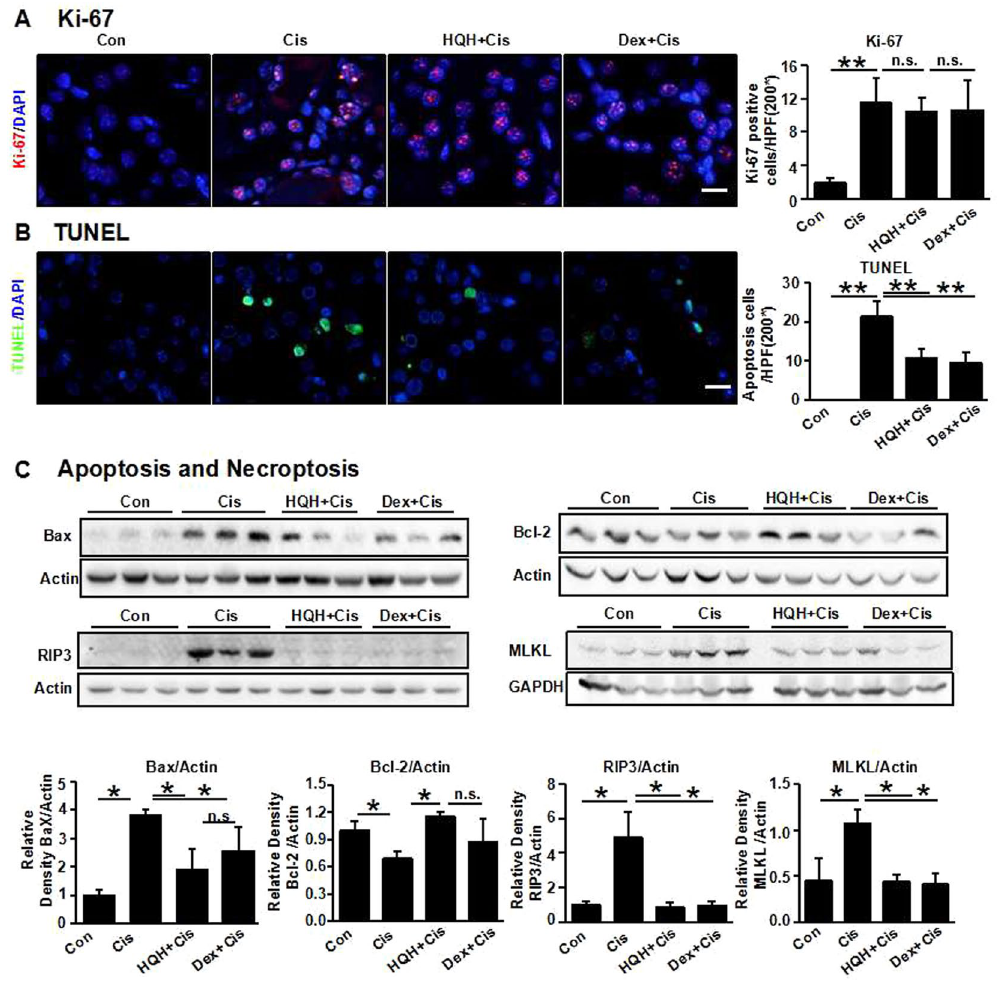
Figure 2. HQH pretreatment protected mice from cisplatin induced tubular apoptosis and necroptosis, but not improved renal tubular epithelial cell proliferation. ( A ) Representative photomicrographs and graphs of immunofluorescence staining for Ki-67. Bar = 50 μ m. ( ** P < 0.01 versus control, n = 8/group). Ki-67 was stained in red and nucleus was counterstained in blue by DAPI. ( B ) Representative photomicrographs and graphs of TUNEL (green) assay for analysis of tubular apoptosis ( ** P < 0.01, n = 5/group). Bar = 50 μ m. ( C ) Representative Western blot and graphs for pro-apoptotic proteins Bax ( C and D , * P < 0.05, n = 3/group), anti-apoptotic protein Bcl-2 ( E and F , * P < 0.05, n = 3/group) and the key element of necroptosis RIP3 ( * P < 0.05, n = 3/group) and MLKL ( * P < 0.05, n = 3/group). Each group of blots is the same exposure of a gel, each group of results repeated more than three